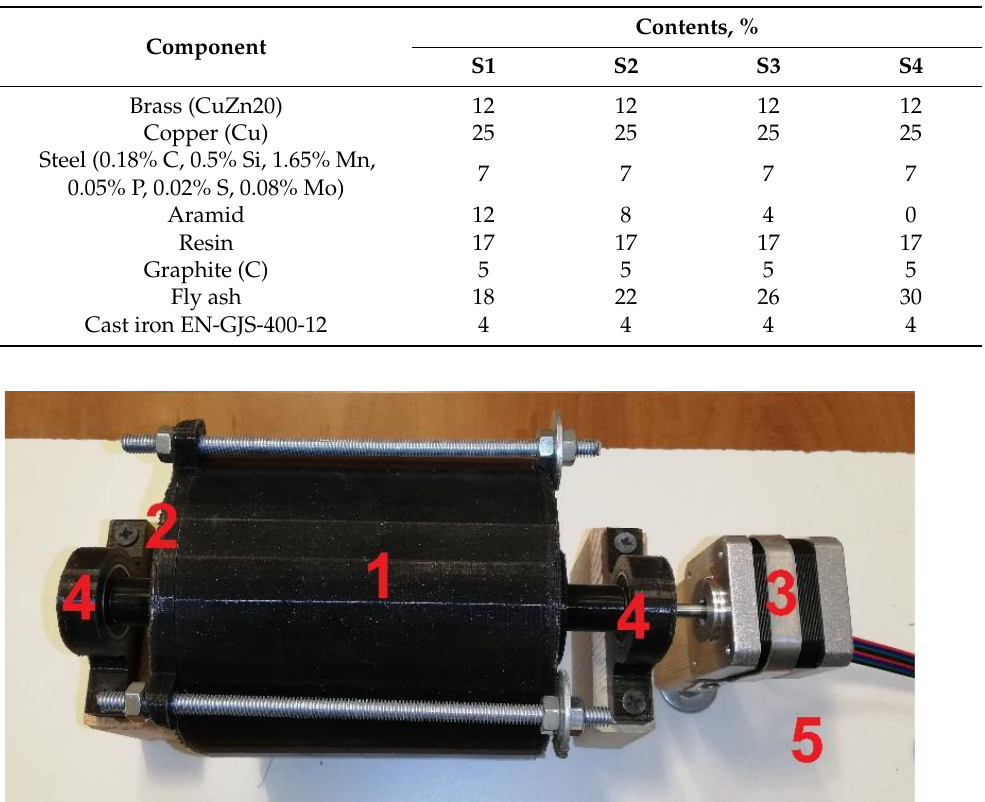
Table 1. Composition of individual groups of samples. Component